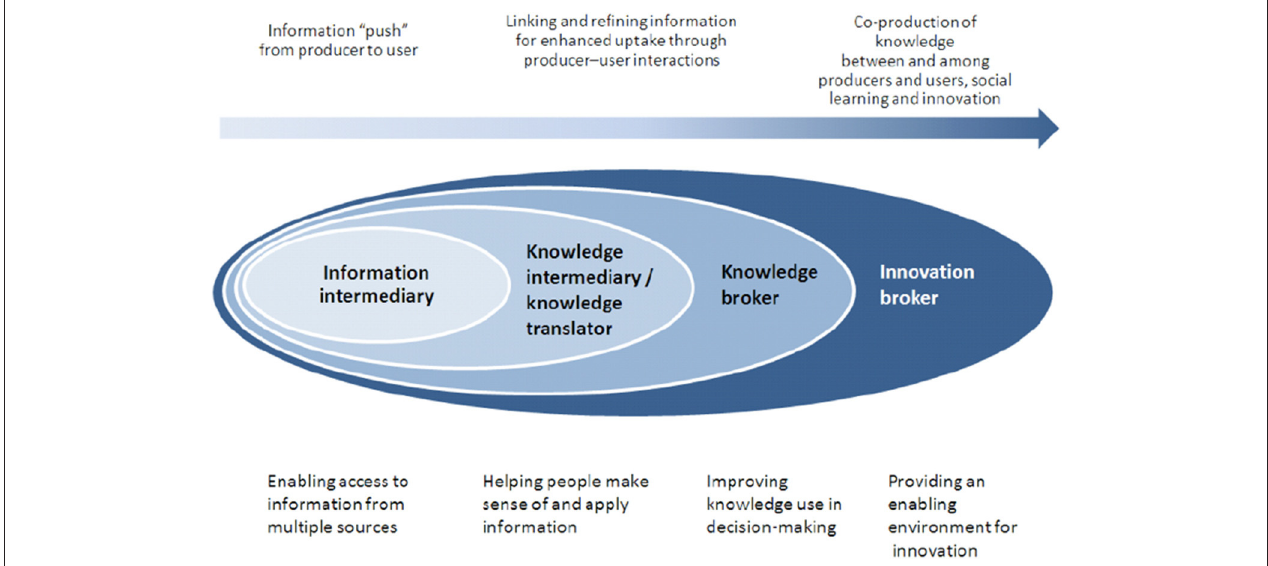
FIGURE 1 | A spectrum of knowledge mobilization approaches (from Hammill et al.,